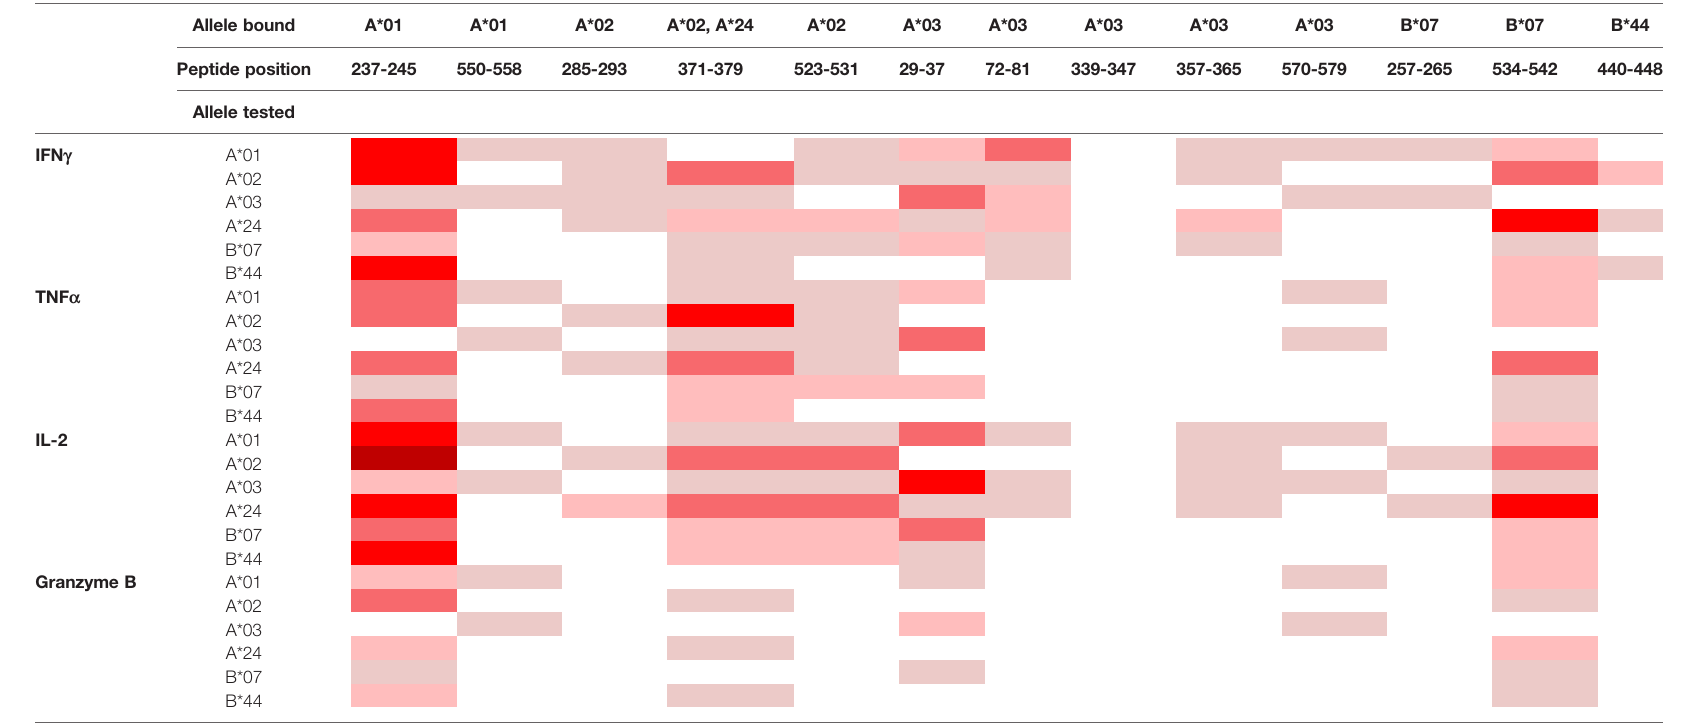
TABLE 5 | Summary of immune response to the class I peptides for PFD0430c by different donor HLA supertypes.